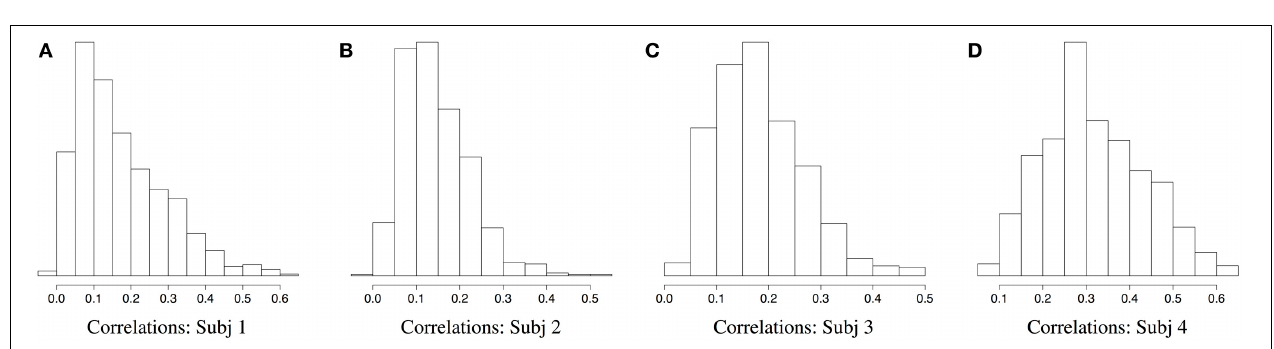
centers of mass of each underlying region and its volume, respectively. The color-coding corresponds to different parts of the brain. (A–F) Shows partial correlation networks within cortical regions, whereas (G–L) shows partial correlation networks within cortical and subcortical regions.